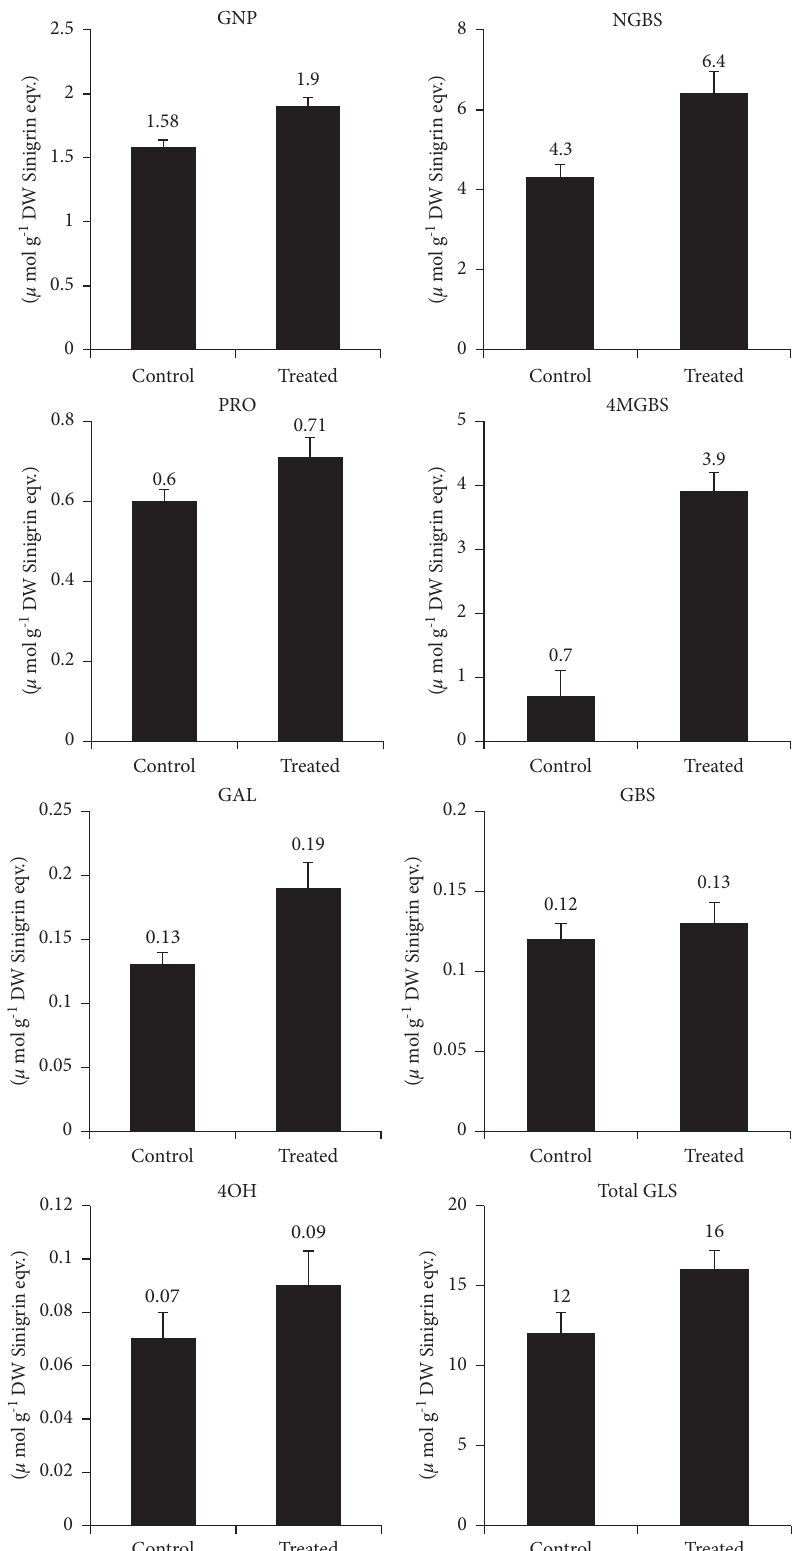
Figure 3: Effect of leaf extracts of Glycyrrhiza uralensis on glucosinolate content of Chinese flowering cabbage under field conditions. Data presented here are mean values of two independent field trials. Vertical bars show standard error, whereas small letters show levels of significance among different treatments as governed by ANOVA and DNMRT at p � 0 .